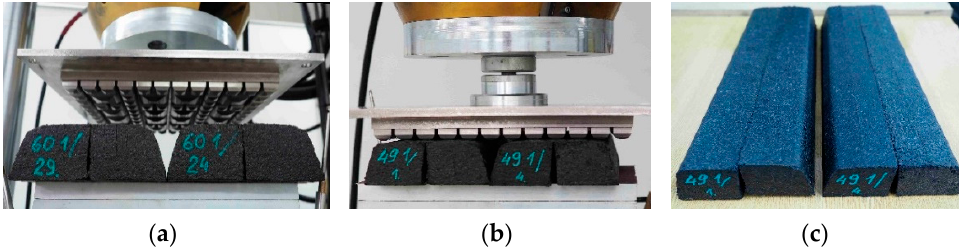
Figure 18. Prototype rail dampers with the elastic cover made of rubber granulate SBR 1050 during the test of resistance in contact with ballast grains: ( a ) Rail dampers adjusted to the Vignole rail 60E1 before the test; ( b ) Rail dampers adjusted to the Vignole rail 49E1 during the test; ( c ) Rail dampers adjusted to the Vignole rail 49E1 after the test—no visible damages or permanent deformations.